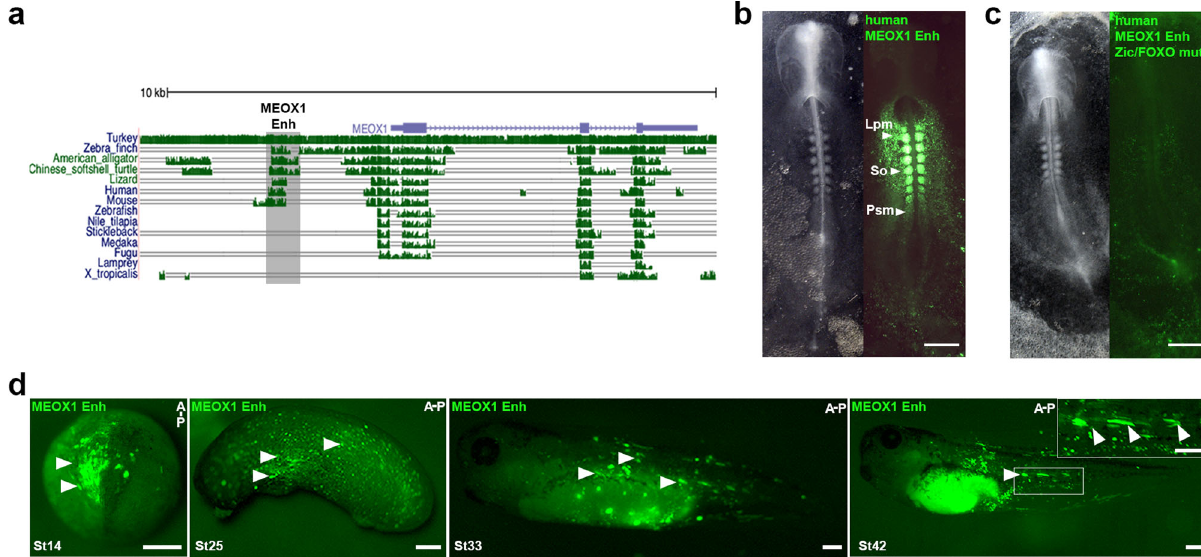
Fig. 7 Evolutionary conservation of MEOX1 enhancer and regulatory mechanism across vertebrates. a Genomic alignment of chick MEOX1 locus, ~10 kb. Exons and introns are represented by blue boxes and lines. Clustered green vertical lines indicate sequence identity between different species. The height of bars indicates extent of conservation in different species: turkey, zebra fi nch, American alligator, Chinese softshell turtle, Lizard, Human, Mouse, Zebra fi sh, Nile tilapia, Stickleback, Medaka, Fugu, Lamprey and Xenopus tropicalis , as indicated on the left of each row. Grey shading indicates the location of the MEOX1 Enh. b Expression of the conserved human MEOX1 Enh reporter in presomitic mesoderm, somites and lateral plate mesoderm in a HH9 chick embryo ( n = 6/6). c Mutation of FOXO1 and ZIC3 binding sites in the human MEOX1 Enh Citrine reporter led to loss of expression ( n = 4/4). d Chick MEOX1 Enh reporter injected into 1 cell of a Xenopus laevis 2-cell embryo shows Citrine expression in paraxial mesoderm (St14, white arrowheads ( n = 6/ 6)) and in early somites and elongated myo fi bres (St25 ( n = 6/6), St33 ( n = 6/6), St42 ( n = 6/6), white arrowheads). A-P anterior – posterior. Scale bars for b , c = 500 μ m, d scale bar = 250 μ